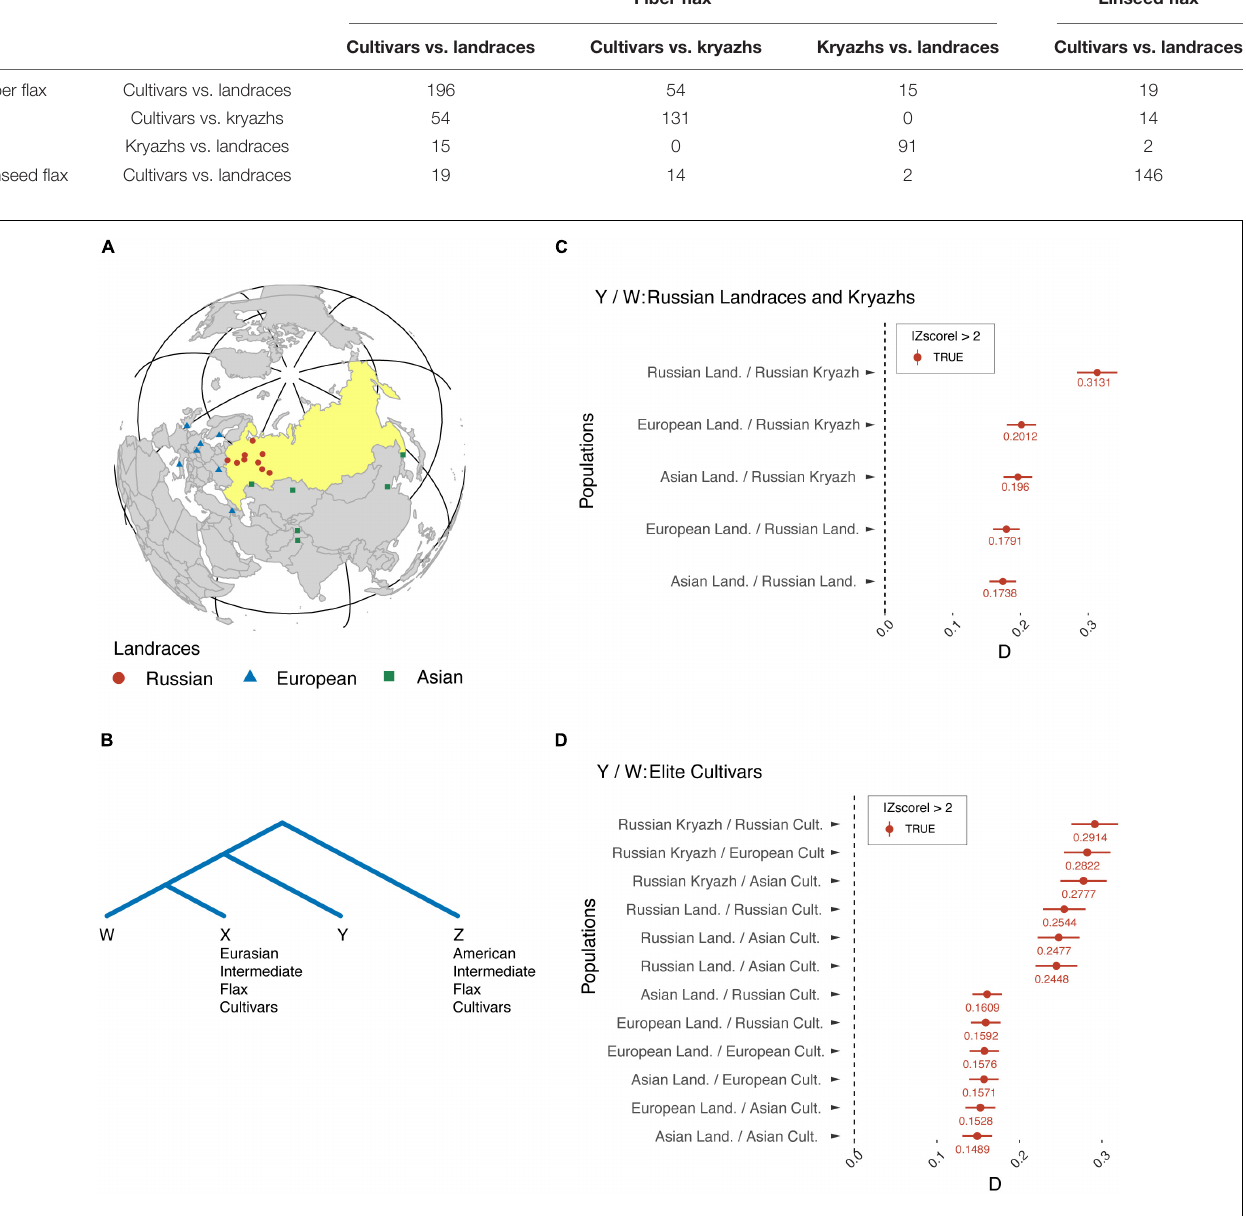
TABLE 2 | Number of shared candidate regions between comparisons.